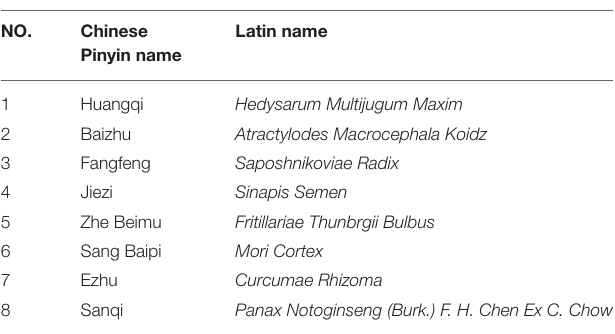
TABLE 1 | Prescription of